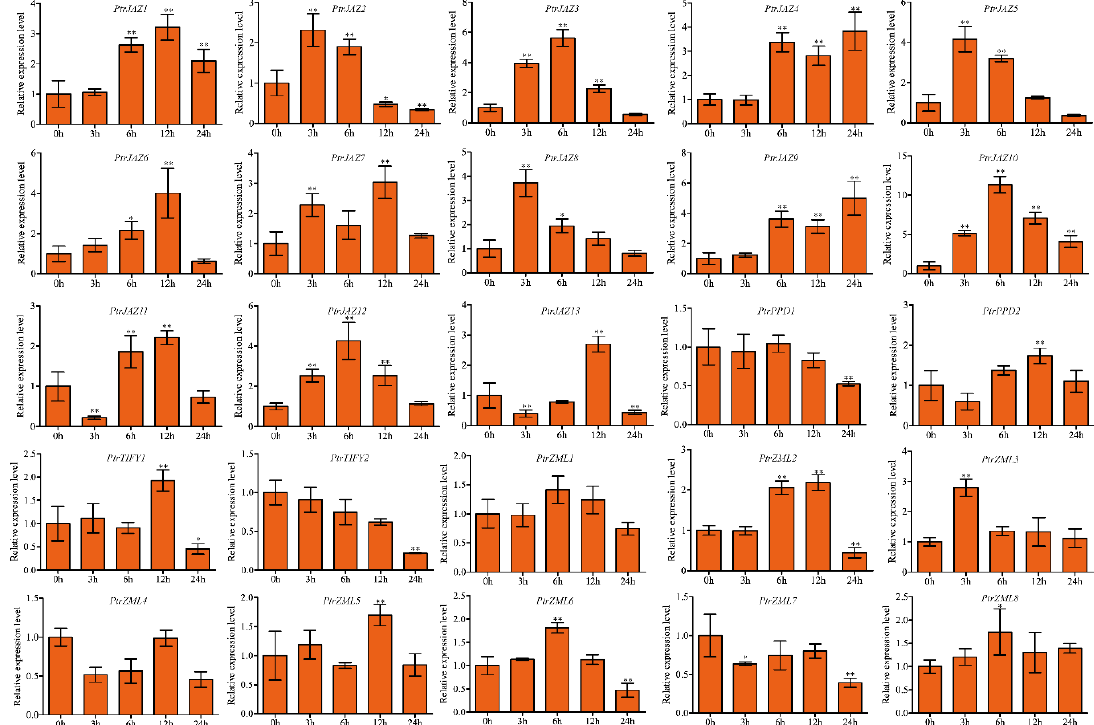
Figure 4. Expression analysis of PtrTIFY genes in root under drought stress by qRT–PCR. Error bars represent the standard deviations from three biological replicates. Asterisks indicate stress treatment groups that showed a significant difference in transcript abundance compared with the control group (* p < 0.05, ** p < 0.01).